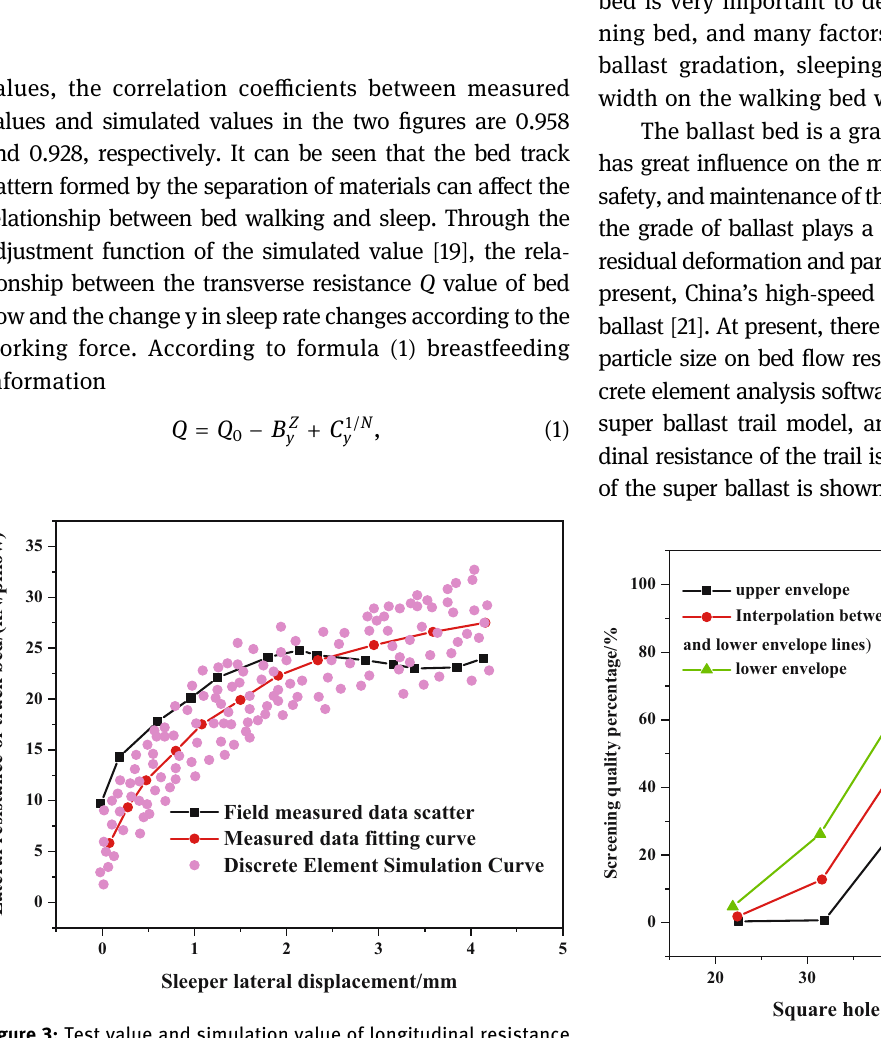
Figure 2: Test value and simulation value of transverse resistance of track bed.